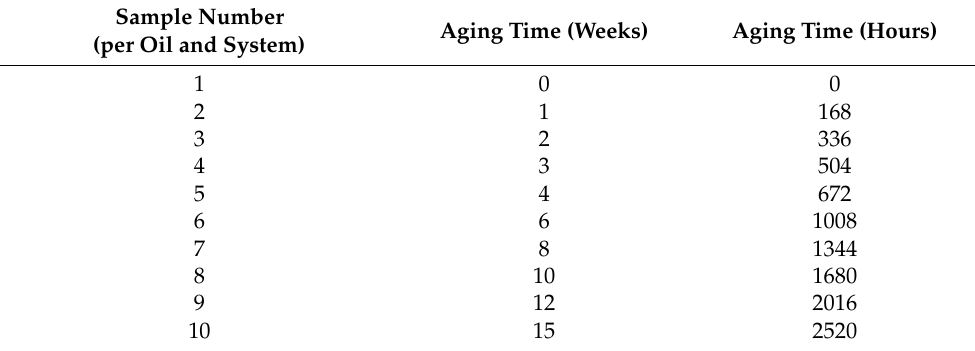
Table 1. Sampling times in weeks and hours.